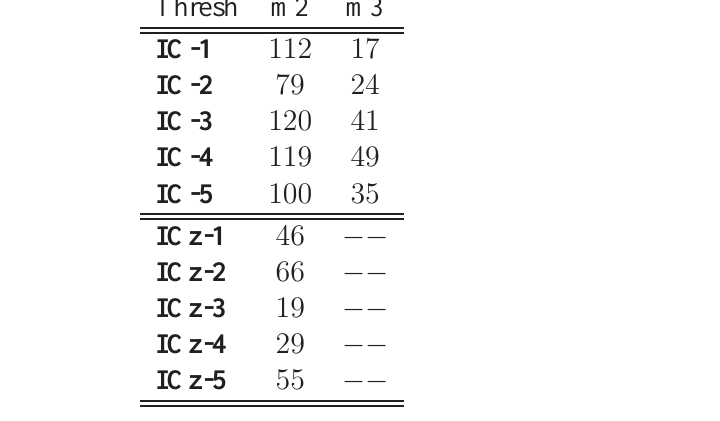
Table 5: Outliers from m2 and m3. No bootstrap here performed. The z-scores are reported